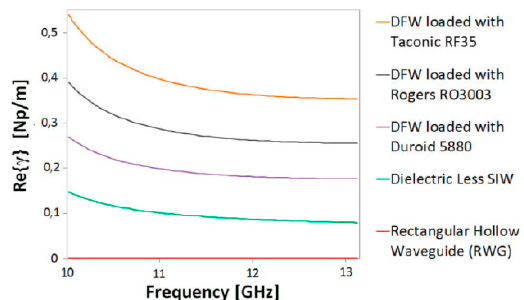
Figure 23. Comparison of the losses due to the dielectric in SIW structures with different substrates and the proposed empty SIW [82]. Conductor losses are neglected.